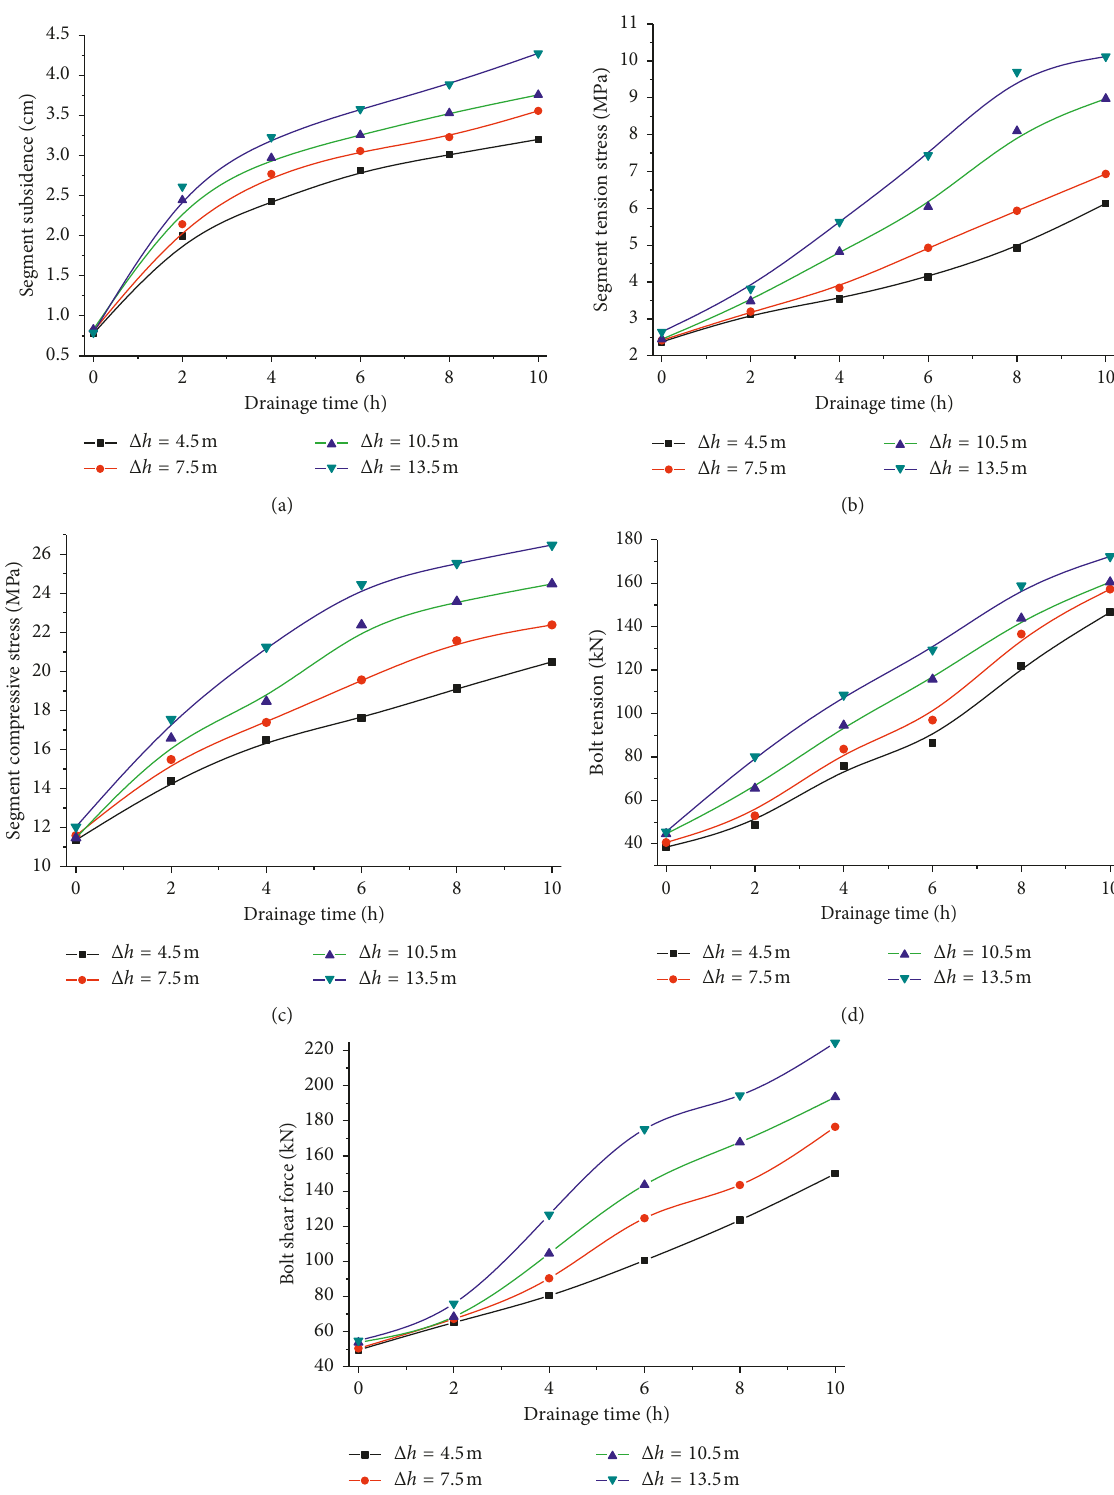
Figure 14: Variation of the deformation and internal force of the segment and the internal force of the bolt with the water inrush time. (a) Maximum deformation of the segment. (b) Maximum tensile stress of the segment. (c) Maximum compressive stress of the segment. (d) Maximum tensile force of the bolt. (e) Maximum shear force of the